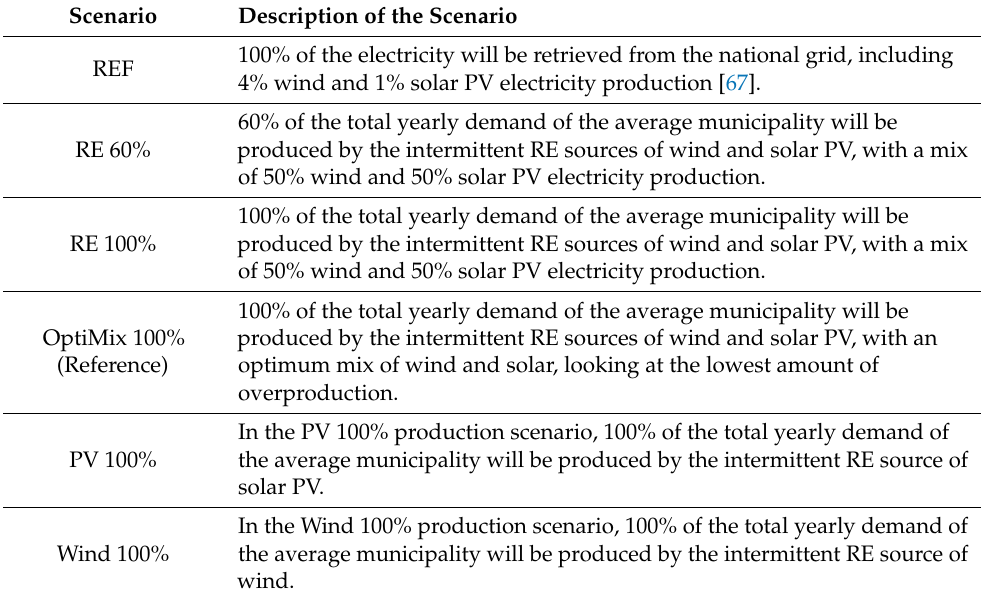
Table 5. The I-RE Municipality Scenarios.